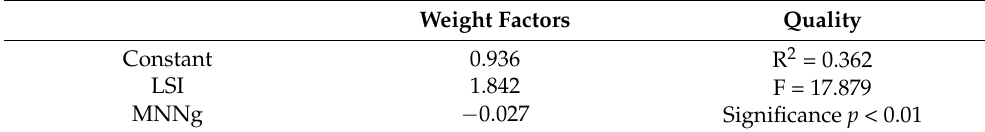
Table 10. Regression analysis results of WCI gradient and impact